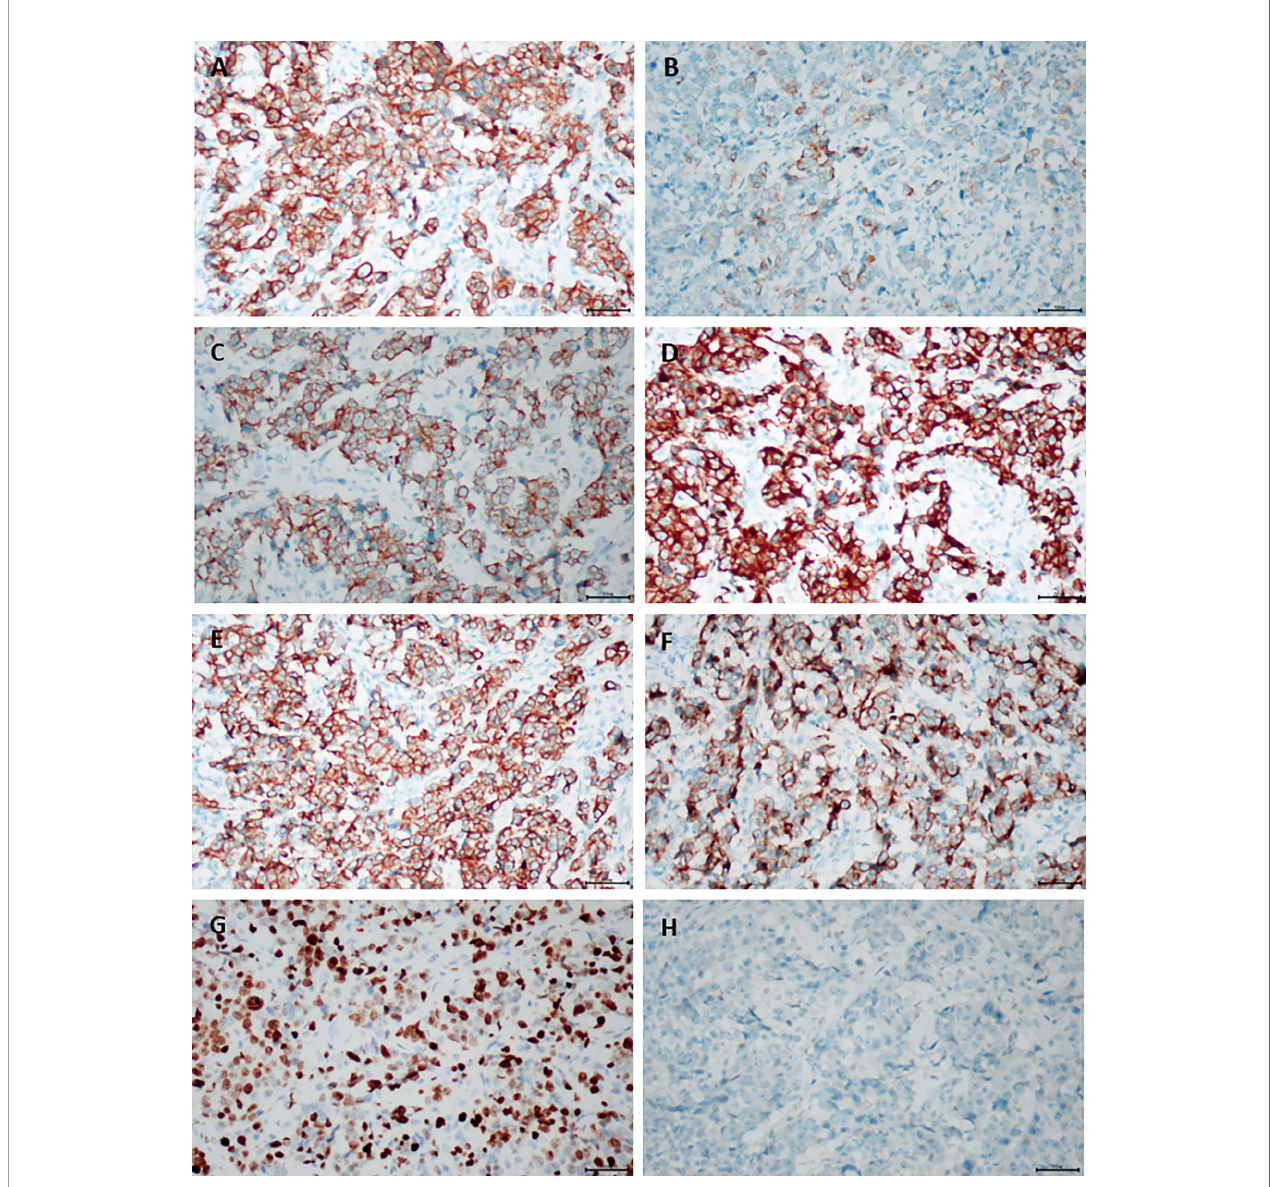
FIGURE 7 | The postoperative immunohistochemical staining results, original magni fi cation ×200. (A) CK (AE1/AE3); (B) CK7; (C) CK8; (D) CK18; (E) CK19; (F) MUc-1; (G) KI-67; (H)